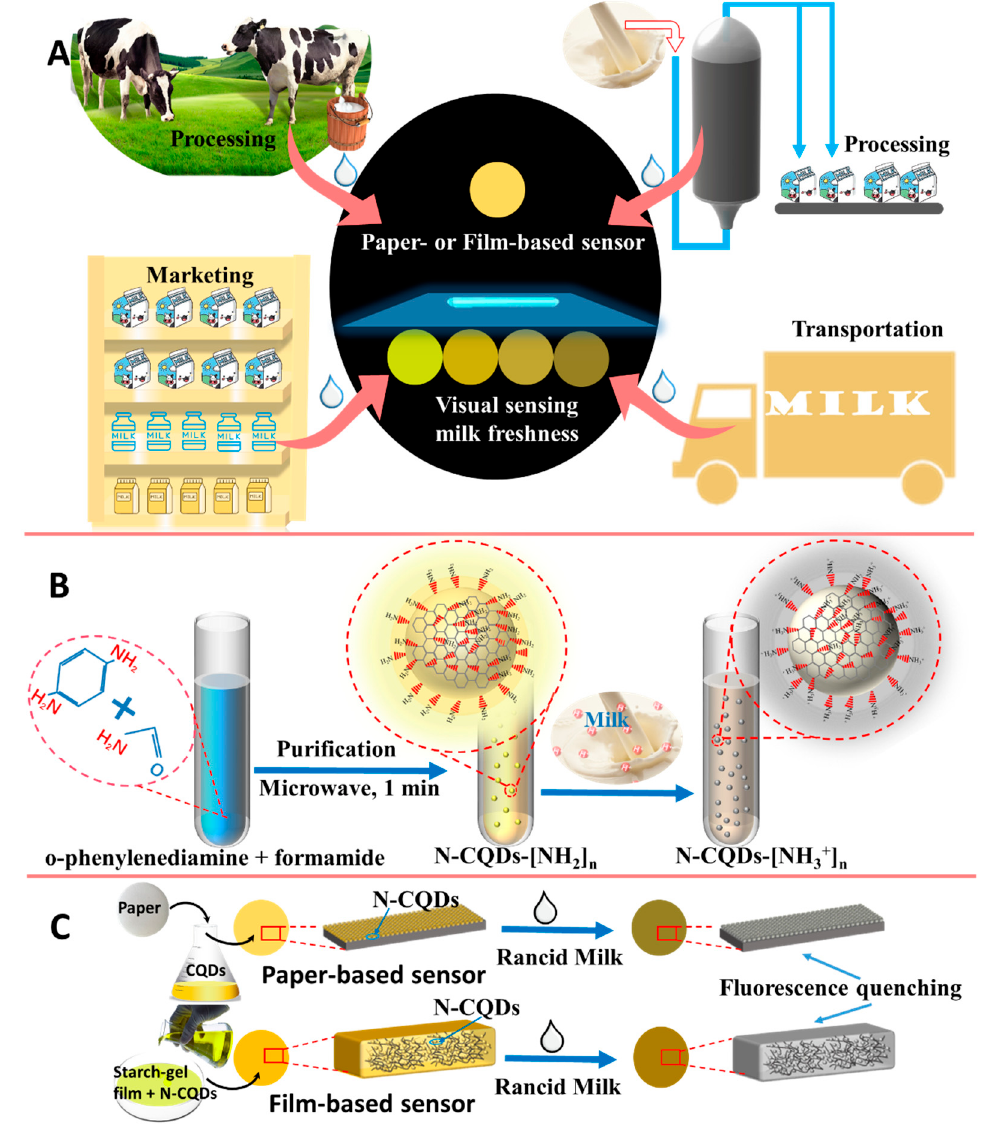
Figure 1. Schematic illustration of ( A ) easy-to-use visual sensing of milk freshness, using fluorescence sensors based on N-CQDs; ( B ) preparation of carbon quantum dots (N-CQDs); and ( C ) the fluorescence quenching of sensors by rancid milk.